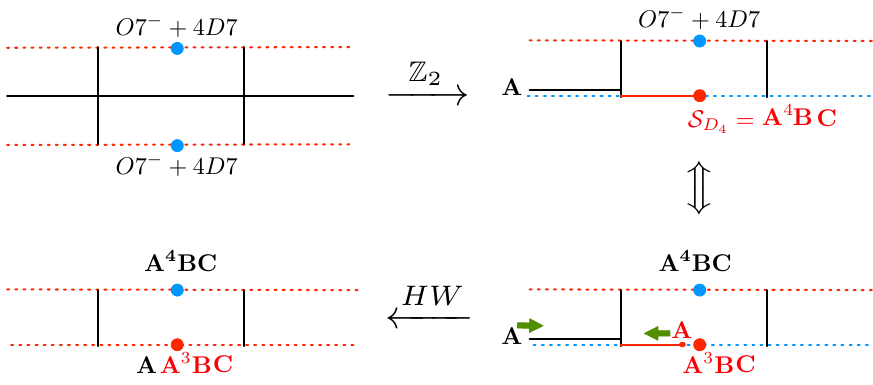
Figure 30 . The Z 2 quotient of 5d Sp(2) + 10 F theory leading to a brane for 5d Sp(1) + 8 F , which is E -string on a circle.